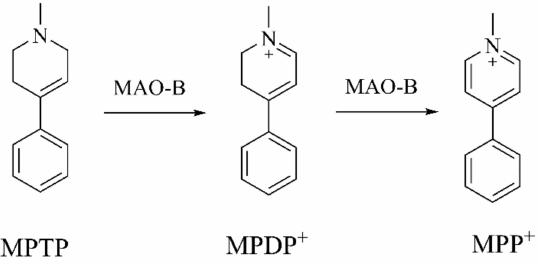
Figure 1. The metabolic process of MPTP